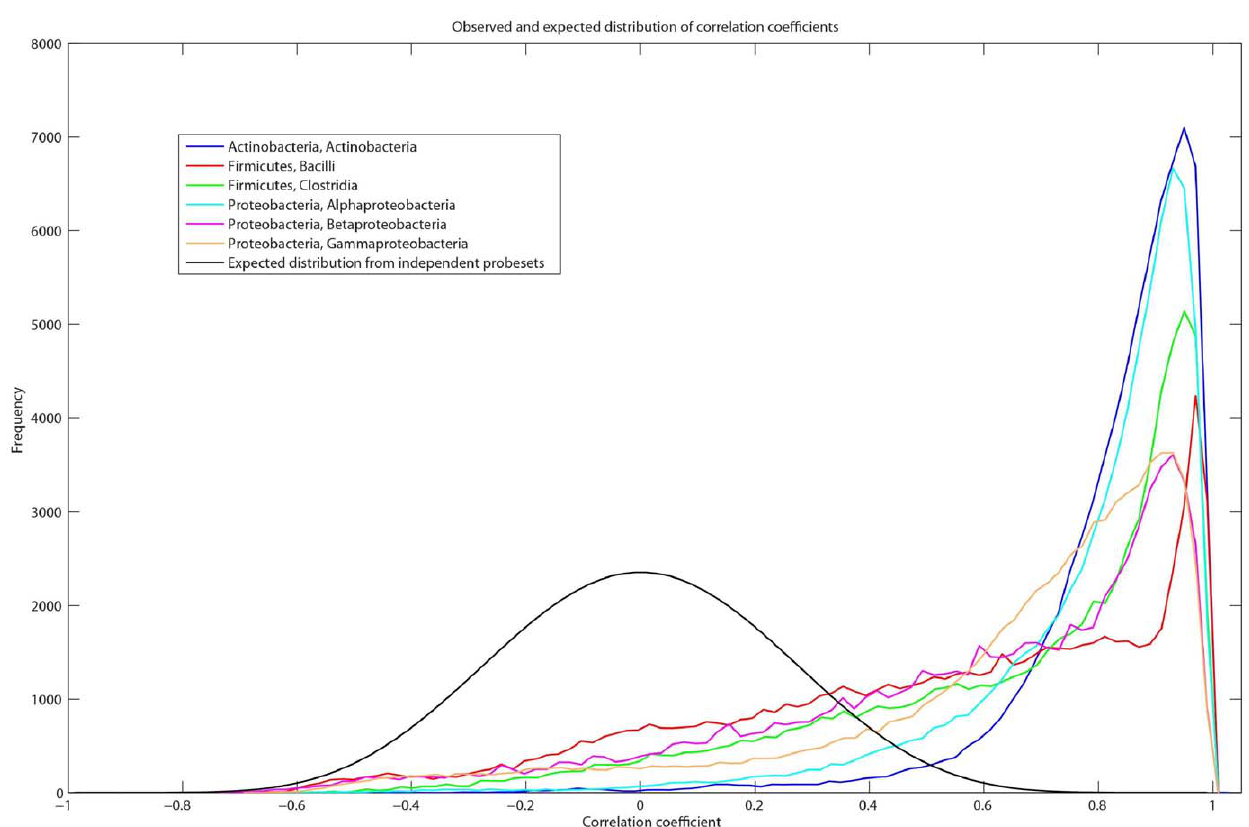
Figure 3. Reanalysis of some of the Texas Aerosol data by Brodie et al [ 3 ] . Observed and expected distribution of correlation coefficients for pairwise comparisons of intensity of detected OTUs within the classes Actinobacteria, Bacilli, Clostridia, Alpha-, Beta- and Gamma- Proteobacteria and the expected distribution of independent probe sets (black).